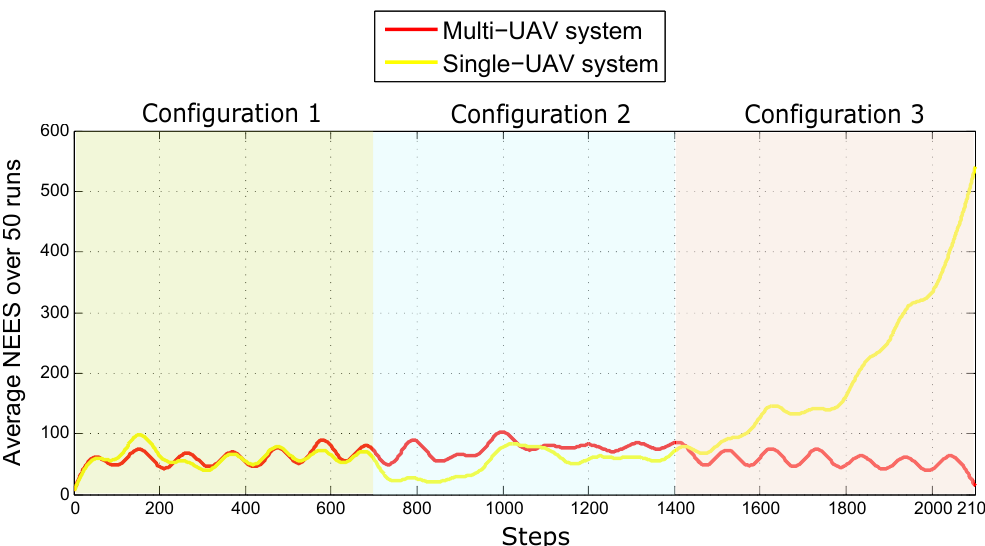
Figure 11. Average NEES obtained with both